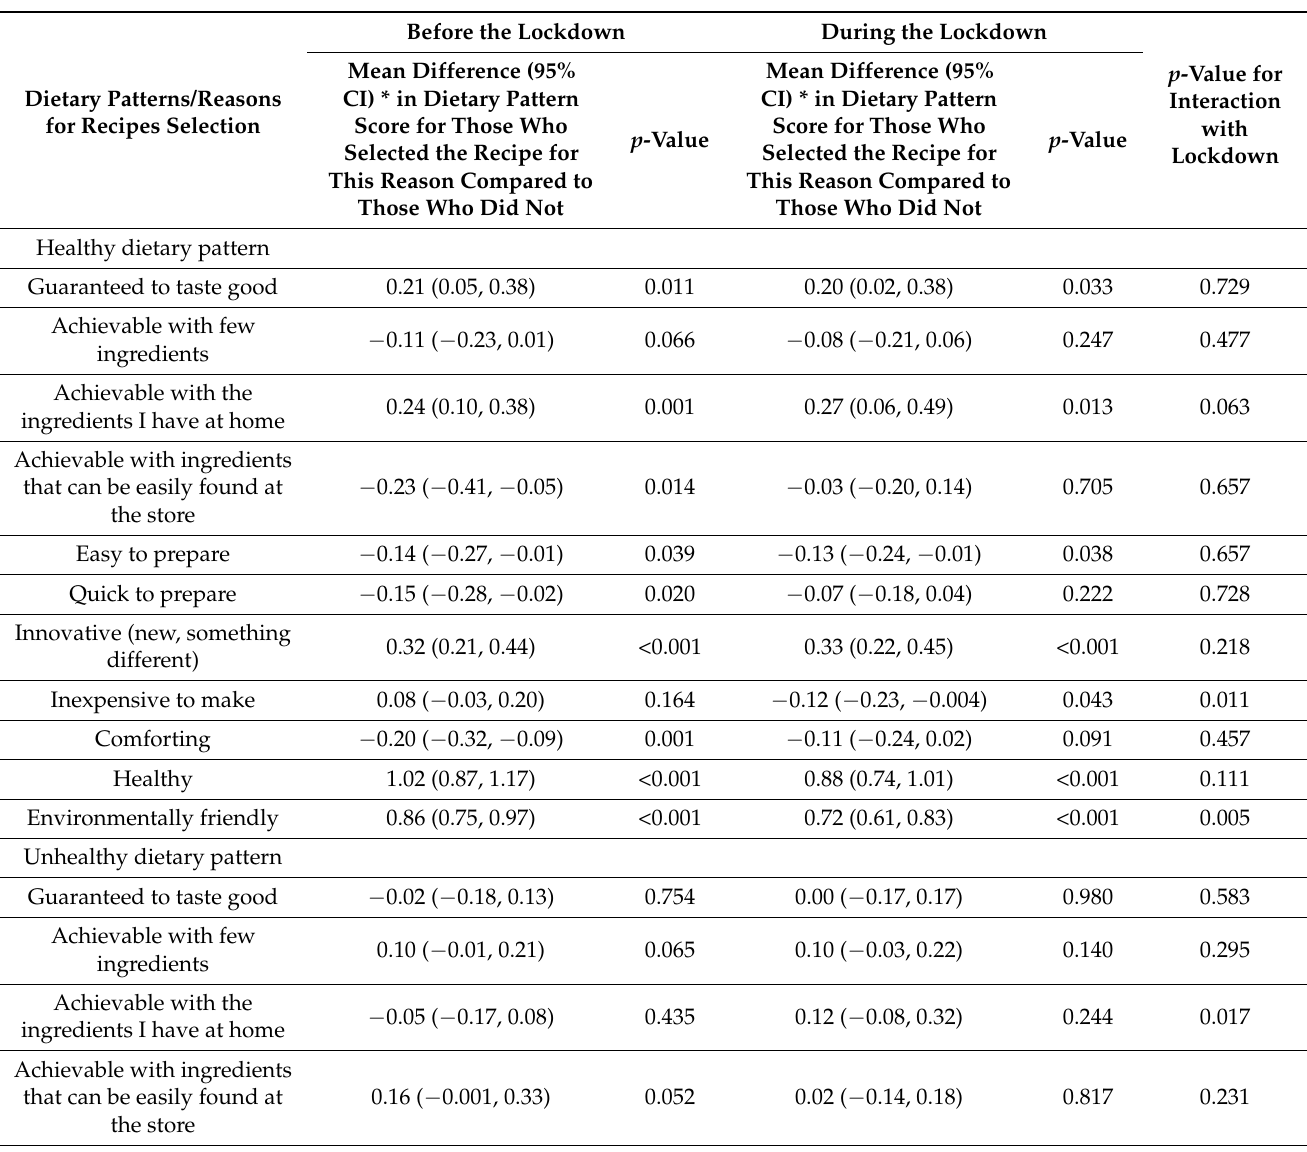
Table 4. Adjusted associations between reasons for recipe selection and scores in the dietary patterns before and during the lockdown ( n =